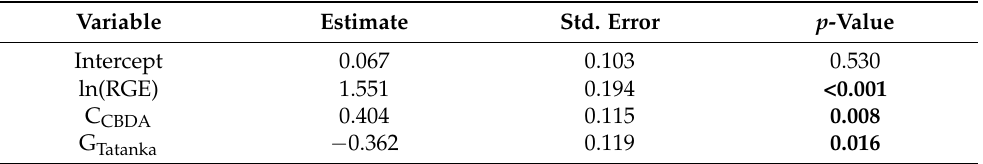
Table 4. Regression coefficient estimates, standard errors, and p -values from LTS fit to cannabinoid relative concentration on relative gene expression (both in log-scale) with cannabinoid type and genotype as covariates. The p -values that denote the statistical significance are in bold.